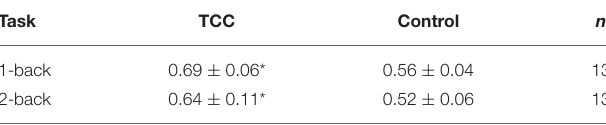
TABLE 3 | N-back task ARs of participants (M ±